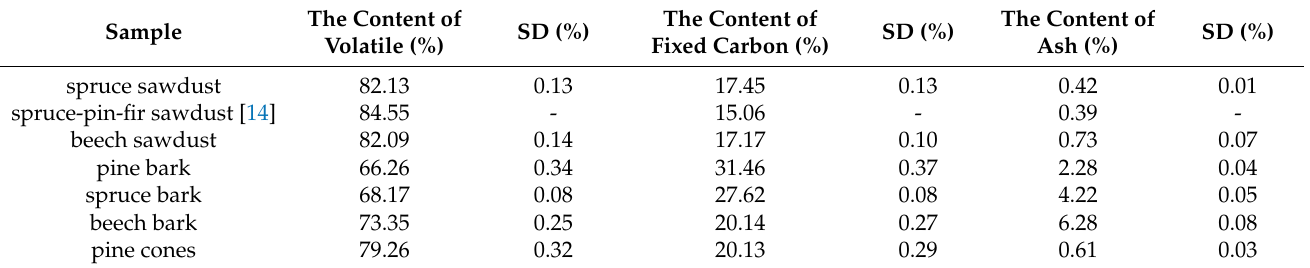
Table 3. Results from TGA analysis of various uncompressed materials based on their dry basis.